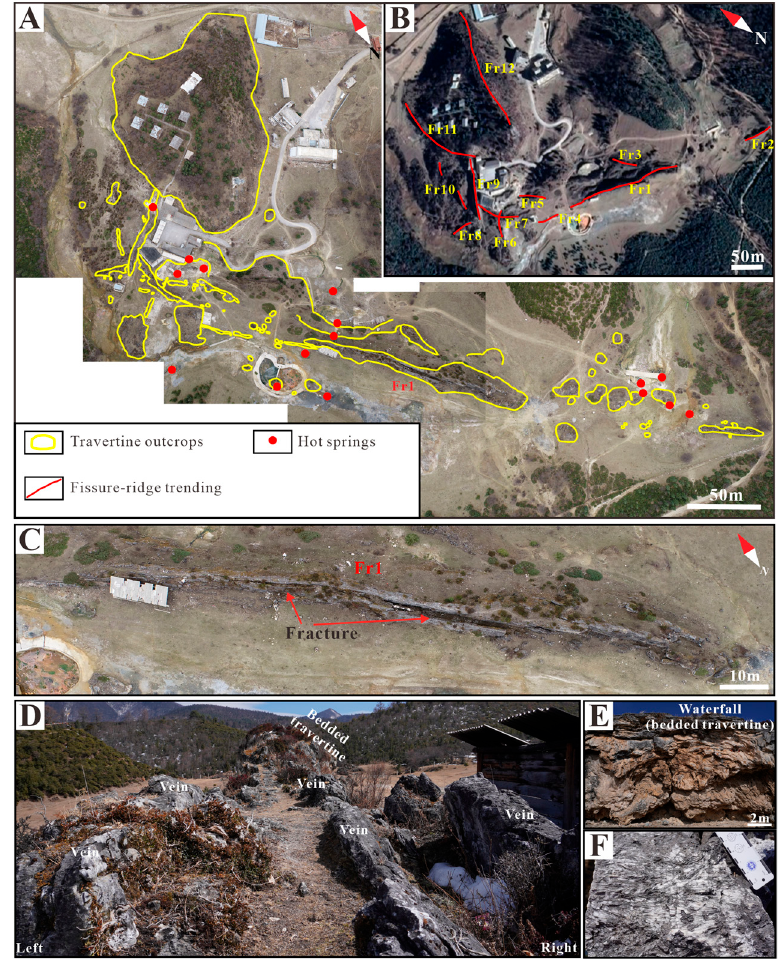
Figure 2. Photographs illustrating the travertine deposits at Xiagei. ( A ) UAV images splicing, indicating the travertine deposit outcrops and the distribution of hot springs. ( B ) An aerial photograph from Google Maps, highlighting the main fissure ridges. ( C ) Images of the studied fissure ridge travertines. ( D ) A general view of the fissure-ridge-type travertines at Xiagei with banded and bedded travertines. ( E ) Examples of travertine waterfalls with thick-bedded travertines. ( F ) Details of thick-laminated palisade crystalline crust.